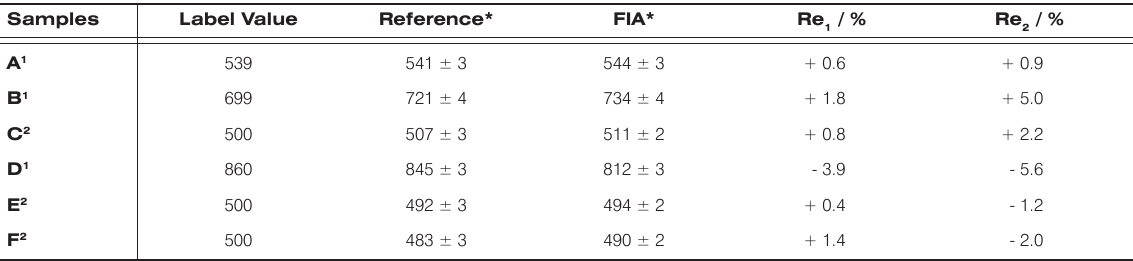
Table 3. Mean results obtained for the determination of dipyrone in pharmaceutica l formulations by FIA spectrophotometric procedure in comparison with the official method. Samples